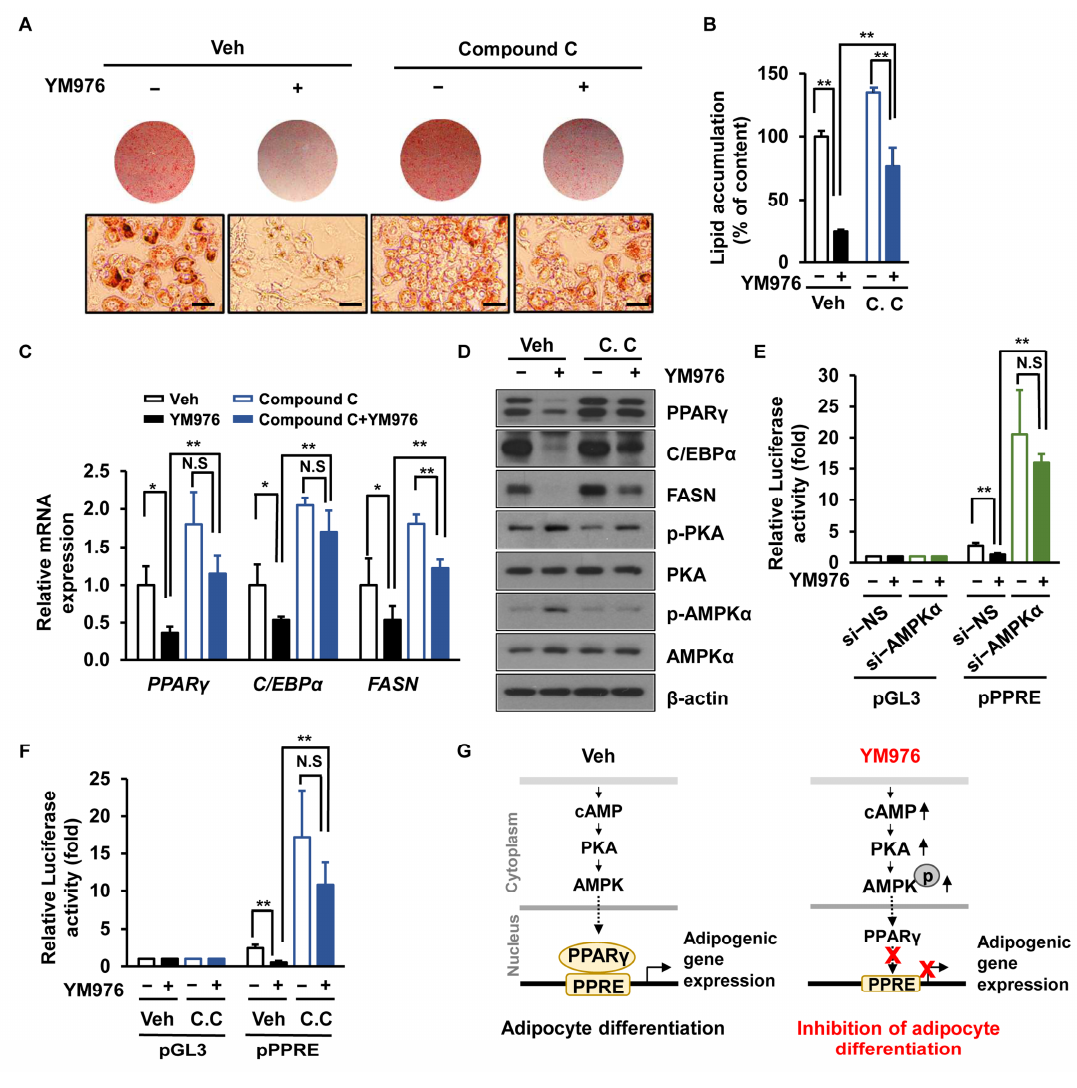
Figure 5. AMPK inhibitor lessens the inhibitory effect of YM976 on adipocyte differentiation. ( A – D ) Cells were pre-treated with Compound C (1 µM) for 1 h and then incubated with YM976 during adipocyte differentiation for six days. ( A ) Cells were stained with Oil Red O and observed by microscopy. Scale bar = 100 µm. ( B ) Quantification of Oil Red O staining by spectrophotometry. ( C ) The mRNA expression levels of PPAR γ , C/EBP α , and FASN were examined by qRT-PCR. ( D ) Levels of indicated proteins were analyzed by immunoblotting. ( E ) After silencing with si-NS